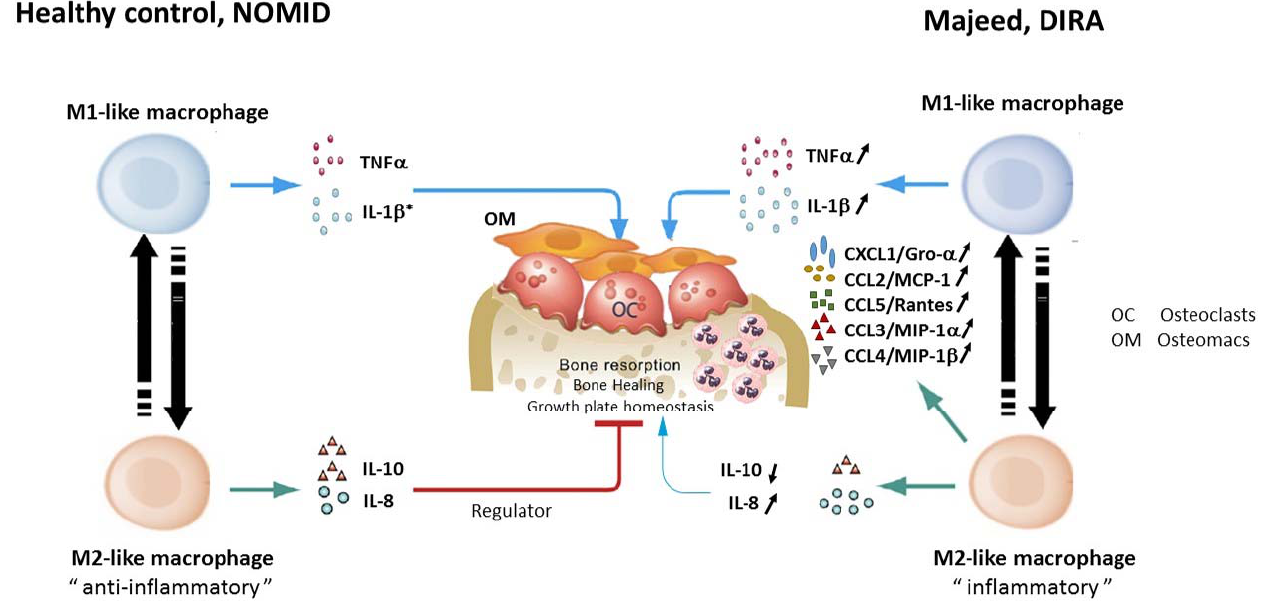
Figure 2. Impaired bone homeostasis as a disease model for the osteomyelitis phenotype in Majeed syndrome. In Majeed syndrome proinflammatory M2-like macrophages produce increased amounts of IL-8 and osteoclastogenic chemokines and lower IL-10 levels thus shifting towards a pro-inflammatory “environment”. The increased production of chemokines such as CXCL1 with IL-8 lead to recruitment of neutrophils while MCP-1 and MIP-1 α / β recruit monocytes and affect macrophage differentiation. The chemokines released by the inflammatory M2-like macrophages further propagate osteoclastogenesis leading to the bone destruction seen in Majeed syndrome and DIRA. In contrast, the M1-like macrophages in NOMID (an NLRP3 inflammasomopathy) also produce increased IL-1 β , yet the M2-like macrophages are not inflammatory and osteoclastogenesis is not increased thus osteomyelitis is not part of their phenotype. (Reprinted from Bhuyan et al. Arthritis and Rheumatology, 2021—Reference